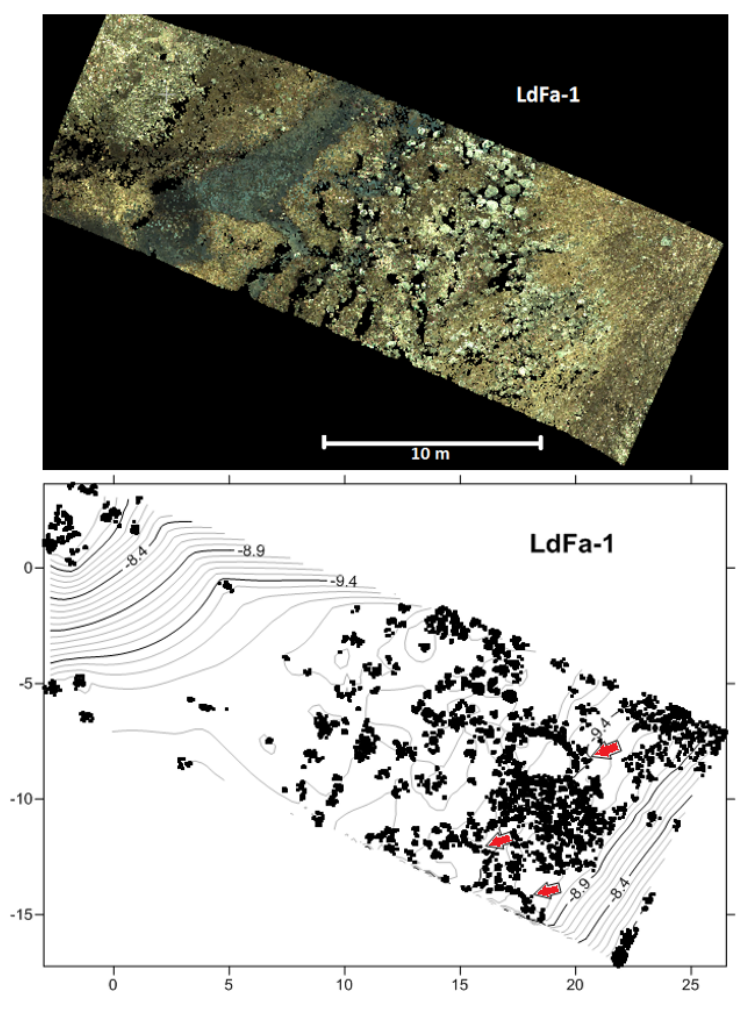
Figure 4: Top: Original point cloud sample from LdFa-1. Bottom: Extracted stone boulders from the point cloud and layered on top of a surface contour map. Arrows indicating the location of stone tent rings near the right side of the map. Scale is in